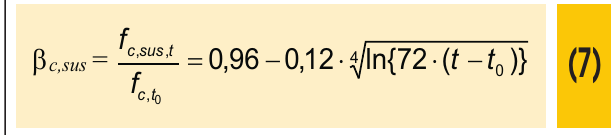
Figure 4 – Compressive strength (product b · b ·f ) as a function cc c,sus cm of long term axial loading (Rüsch